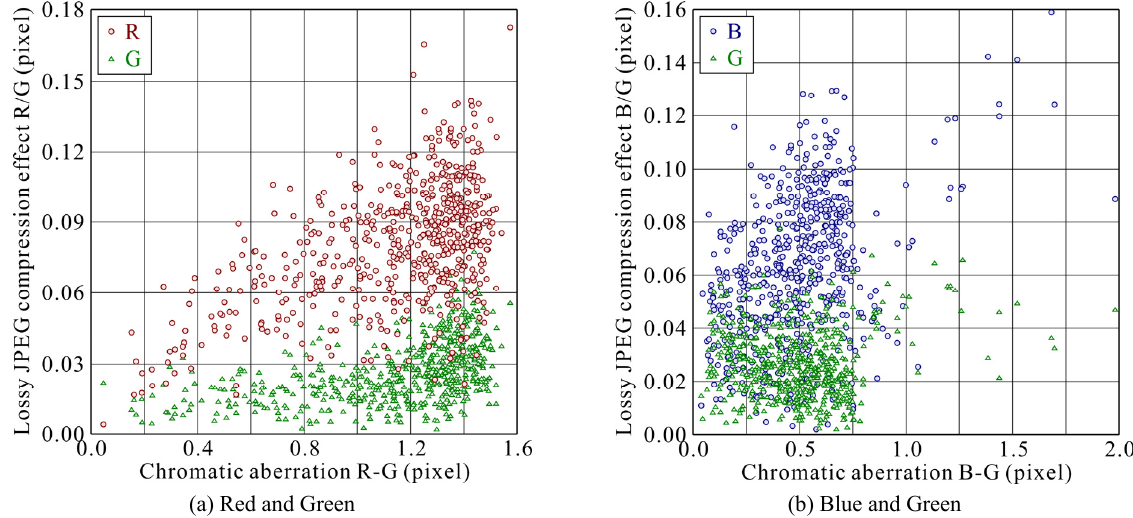
Figure 8. Displacements by chromatic aberration vs. displacements by lossy JPEG compression with 2x1 1x1 1x1 sampling in the image shown in Figure 2 (Mode: